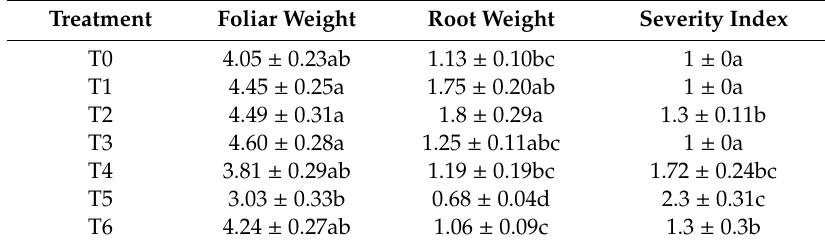
Table 5. E ff ect of the application of EFB isolated from SOA and the SOA product in the promotion of growth and biocontrol of FORL in tomato. The values represent the mean ± standard deviation, calculated based on 15